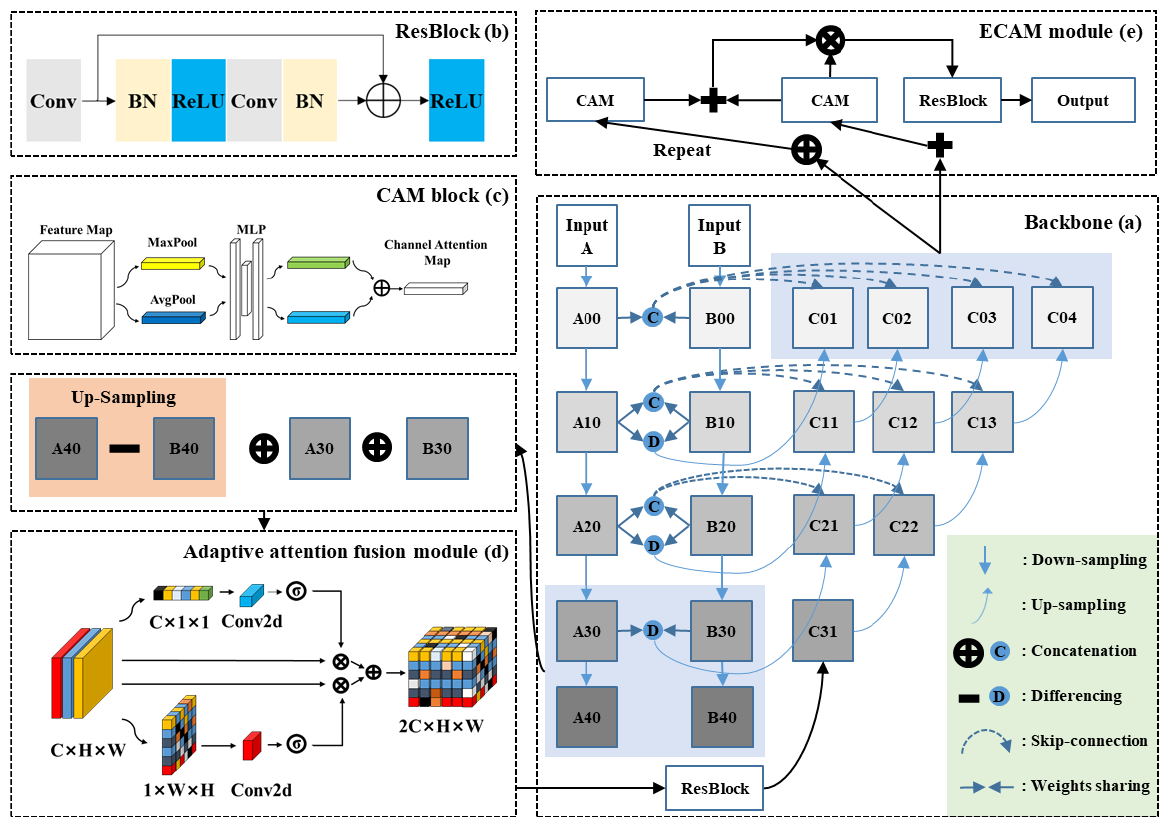
Figure 2 . The proposed network architecture. Part (a) is the backbone of the model; Part (b) is the ResBlock; Part (c) is the CAM block used in Part (e), the ECAM; Part (d) illustrates the adaptive attention fusion